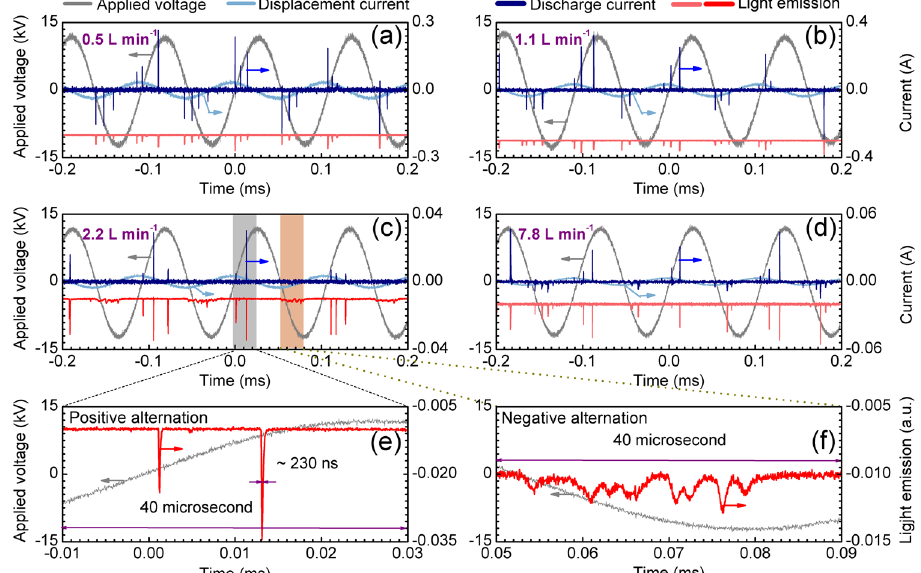
Fig. 2 Electrical characteristics of the plasma source. a Typical waveforms of applied voltage (gray solid line), discharge current (dark blue solid line), displacement current (light blue solid line), and integrated light emission (light red solid line) with the gas fl owrate fi xed at 0.5 l min − 1 . The displacement component is enlarged by ten times. b Same as a , but with the gas fl owrate fi xed at 1.1 l min − 1 . c Typical waveforms of applied voltage (gray solid line), discharge current (dark blue solid line), displacement current (light blue solid line), and integrated light emission (red solid line) with the gas fl owrate fi xed at 2.2 l min − 1 . d Same as c , but with the gas fl owrate fi xed at 7.8 l min − 1 and the light emission indicated by the light red solid line. e The enlarged view of the applied voltage (gray solid line) and light emission (red solid line) marked in the gray shadow in the positive alternation at 2.2 l min − 1 in c . f The enlarged view of the applied voltage (gray solid line) and light emission (red solid line) marked in the orange shadow in the negative alternation at 2.2 l min − 1 in c . The shaded regions are introduced in order to focus the attention on the difference of light emission in the negative alternation from that in the positive